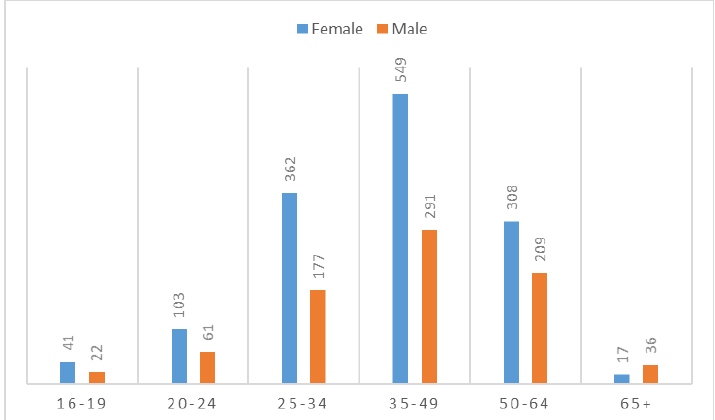
Figure 2. Breakdown of gender and age. The total sum of users (2176) is higher than that given previously as these results were obtained after the ‘Move More Month”